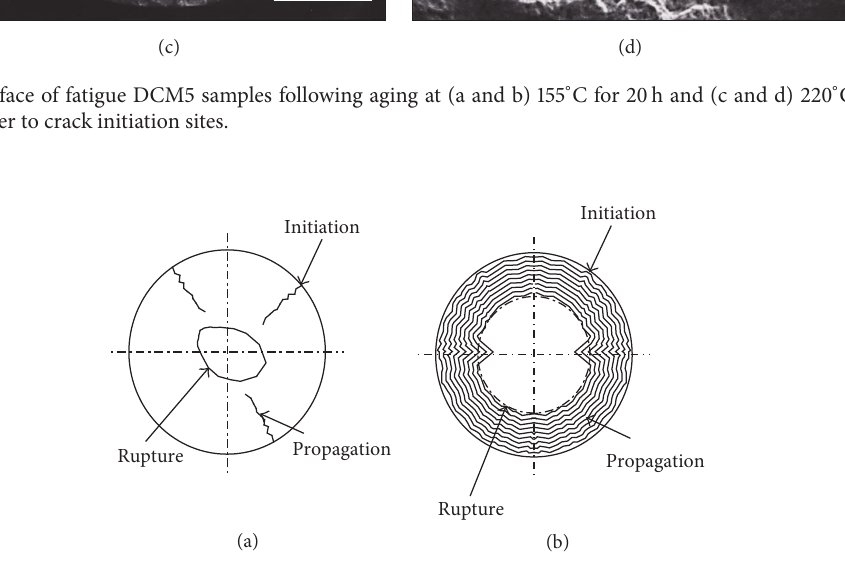
Figure 15: Schematic diagram showing the proposed crack initiation and propagation mechanisms in the present work: (a) several initiation sites and (b) concentric